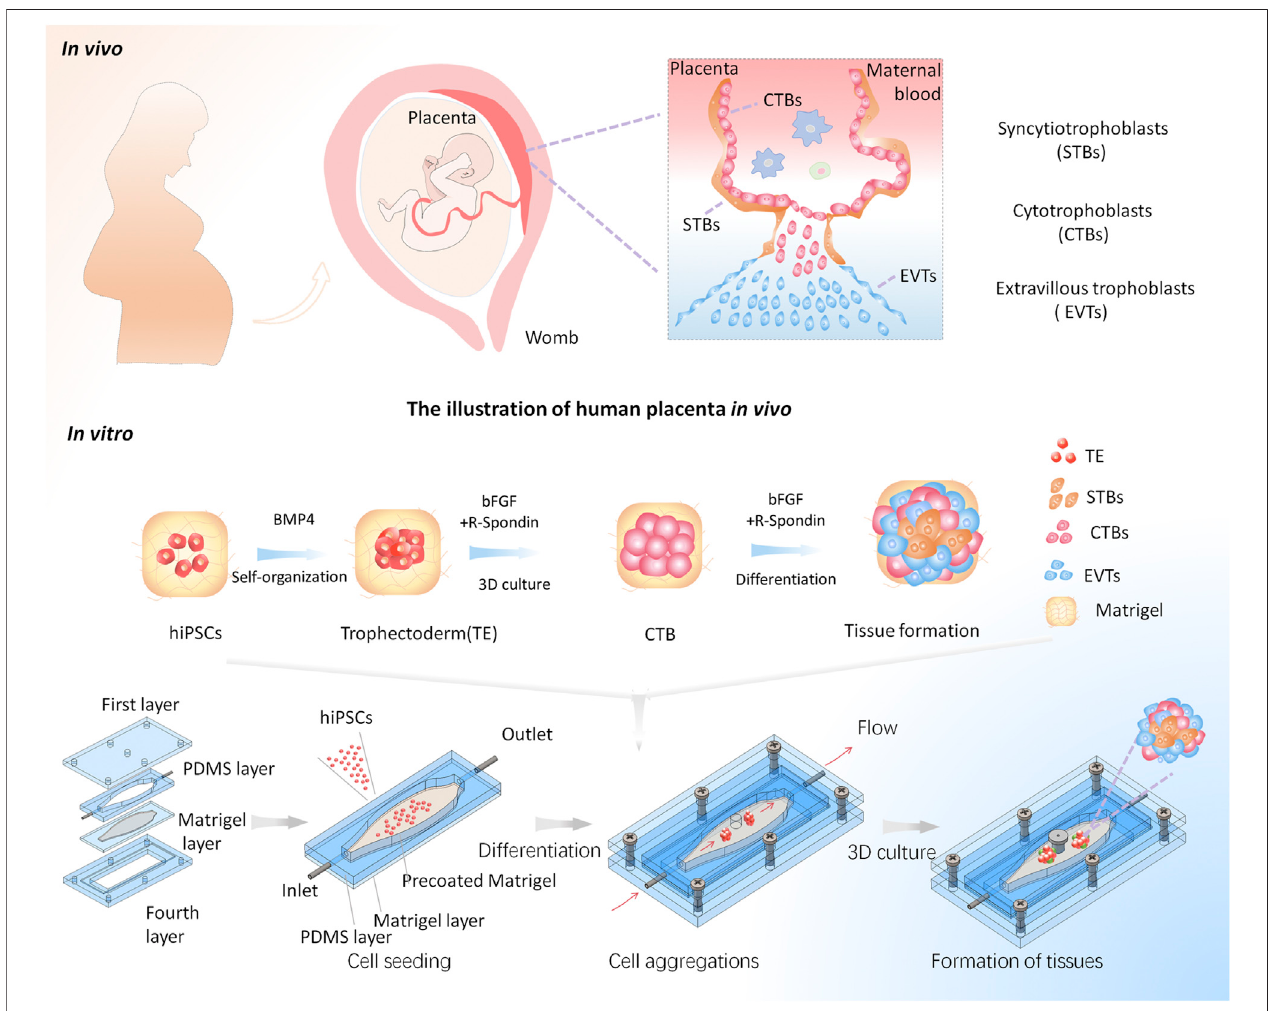
FIGURE 1 | Schematic illustrations of the generation of the placental trophoblast-like tissue model from hiPSCs in a macro fl uidic chip. The human placental trophoblasts invivo comprisevillousCTBs,anouterlayerofmultinucleatedSTBs,andEVTs.ThedifferentiationprocessofhiPSCstowardtrophoblastlineageonthechip mainly includes three stages: hiPSC seeding, cell aggregations, and formation of trophoblast tissues under a dynamic 3D